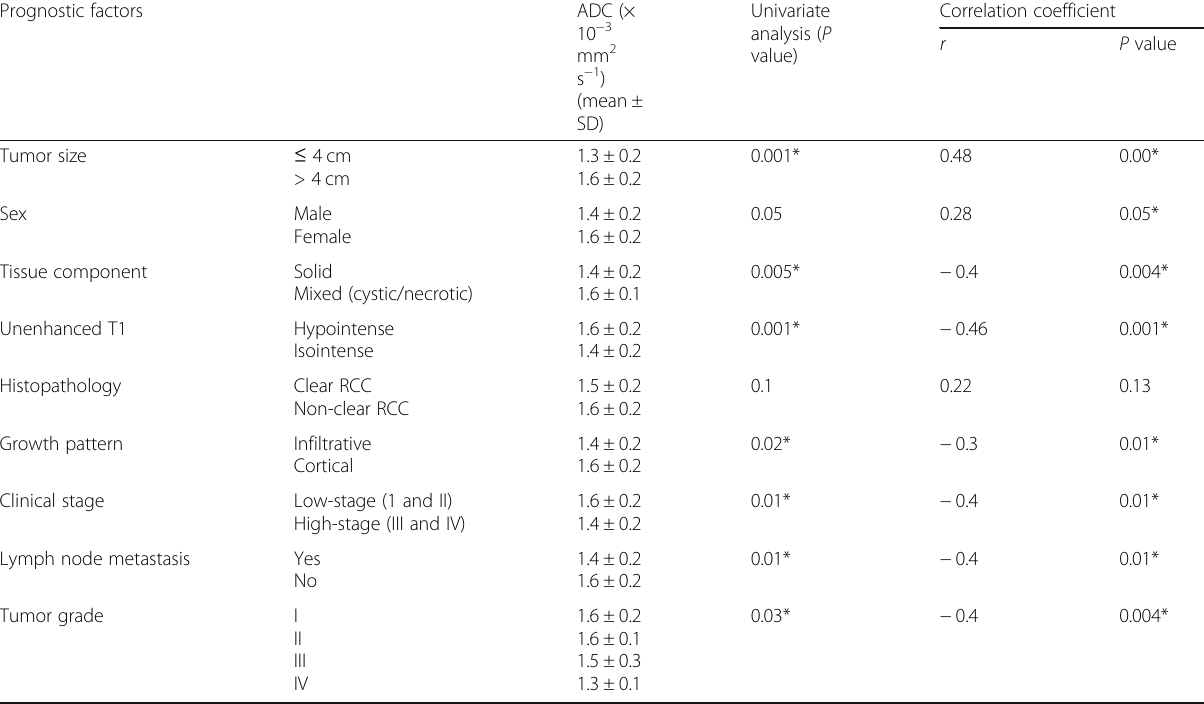
Prognostic factors